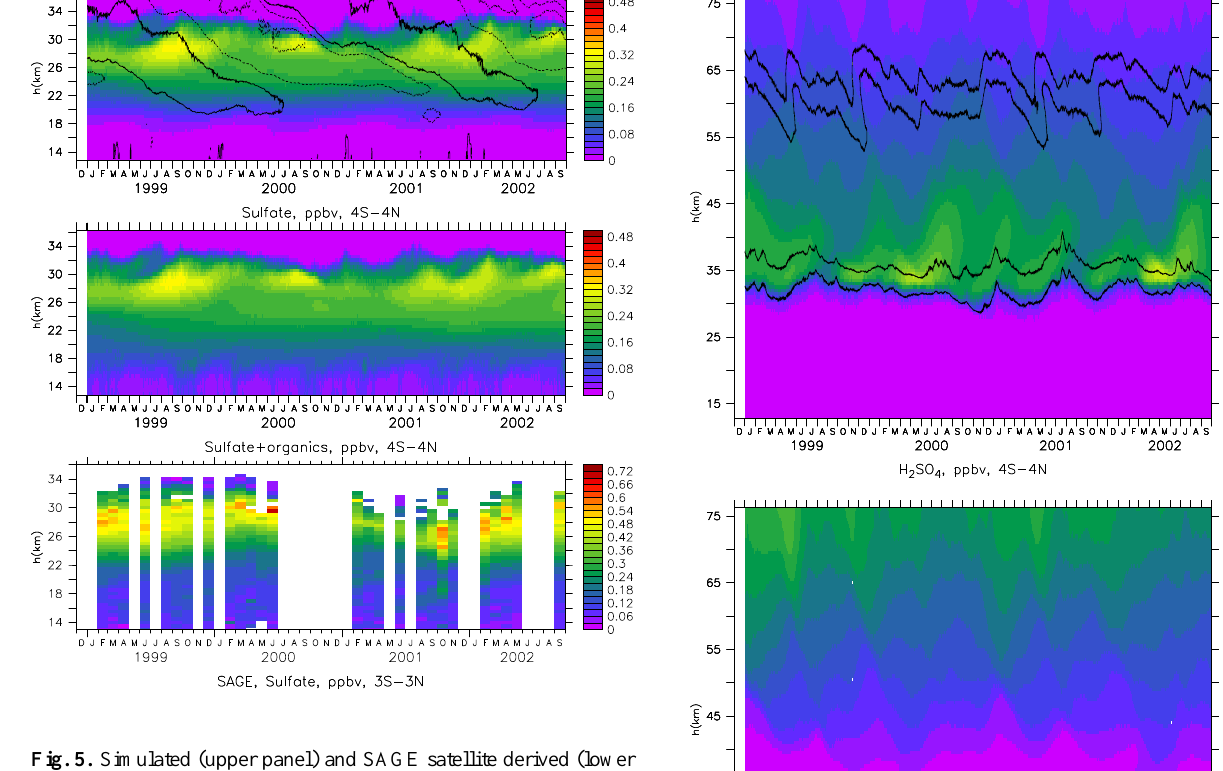
Fig. 5. Simulated (upper panel) and SAGE satellite derived (lower panel) sulphate aerosol in the tropics, ppbv. Black contours give the zonal wind (QBO), in steps of 20ms − 1 , beginning with − 30ms − 1 (dotted contours negative or easterlies). The middle panel includes simulated organic carbon aerosol. Range of color scales as in Fig. 4